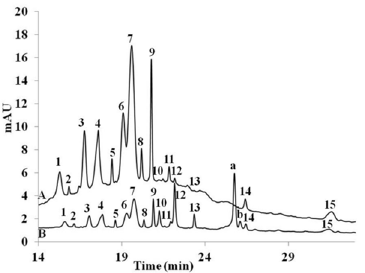
Figure 4. Red grape extract chromatogram (A) prior to cell uptake experiment, (B) extracted from cells following the uptake experiment: 1 = delphinidin-3-glucoside, 3 = cyanidin-3-glucoside, 4 = petunidin-3-glucoside, 6 = peonidin-3-glucoside, 7 = malvidin-3-glucoside, 8 = peonidin-3-glucoside pyruvic acid, 9 = malvidin-3-glucoside pyruvic acid; peaks 2, 5, 10, 11, 12, 13, 14 and 15 were unknown; peaks a, b appeared following uptake experiment.